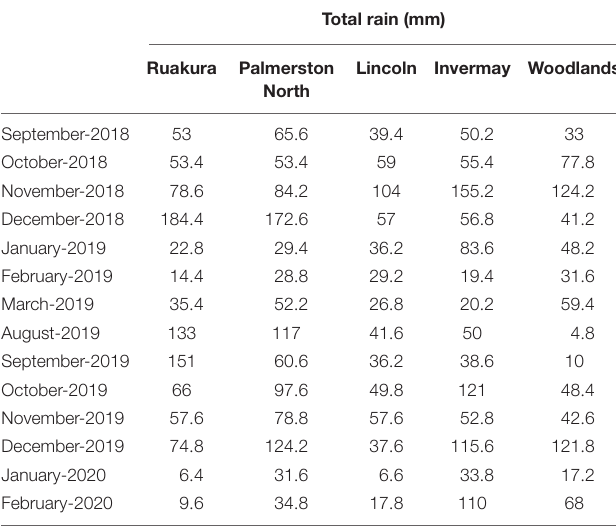
TABLE 2 | Monthly total precipitation at the experimental sites.